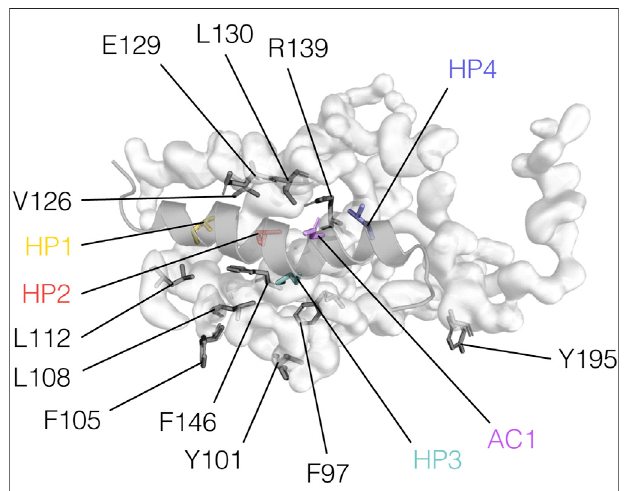
FIGURE4| BH3motifhotspotsand residuesrelevanttotheirinteraction with BCL2 proteins. BH3 hotspots and BCL2 residues are illustrated on the BCLXL/PUMA-BH3complex(PDBID:2M04)andcolor-codedasin Figure1